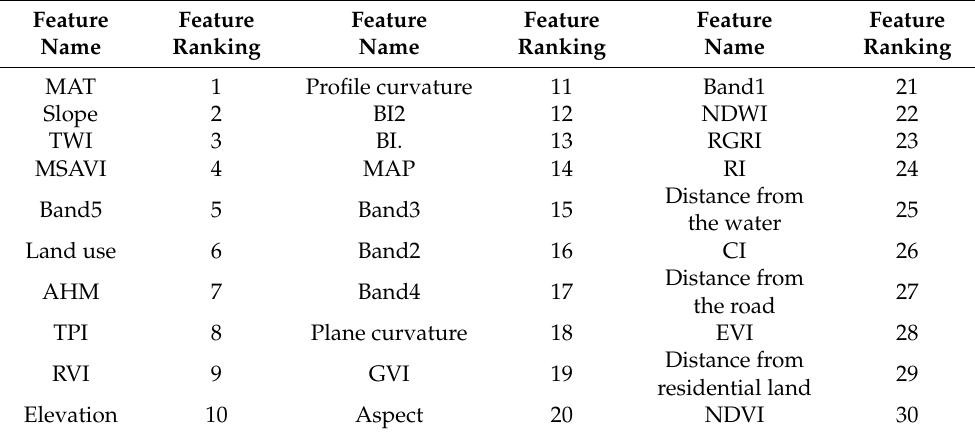
Figure 3. Heat map of the correlation between soil pH and environmental variables (the top right- hand corner is a heat map of the correlation with added significance markers and the bottom left-hand corner is the correlation coefficient r value.). Table 4. The results of the support vector machine recursive feature elimination (SVM-RFE) feature